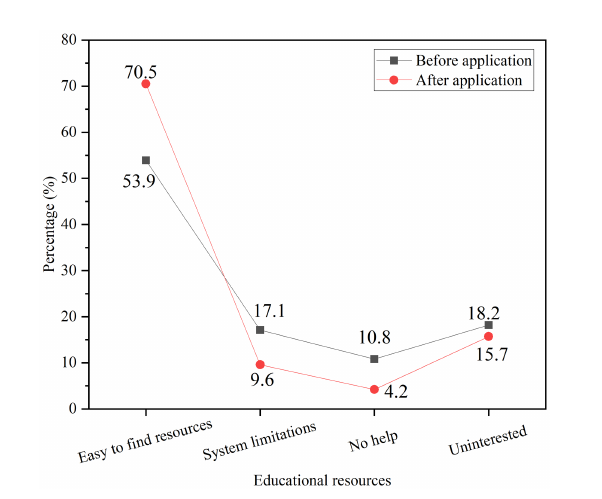
FIGURE 14 Comparison of teaching resource application